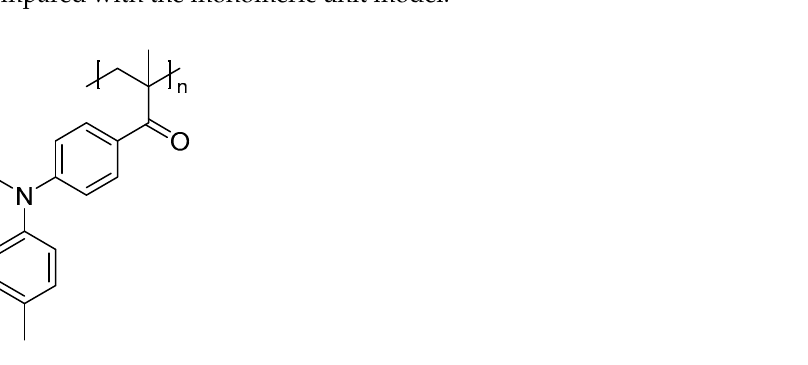
Figure 1. The structure of poly(isopropenyl 4-[bis(4-methylphenyl)amino]phenyl ketone).